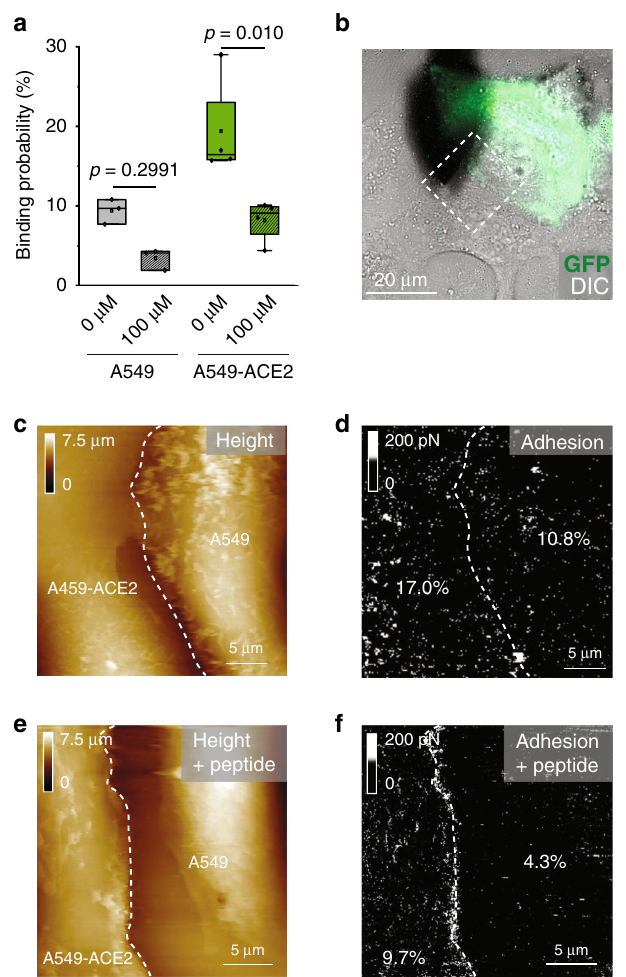
Fig. 5 Blocking of S1-subunit binding using ACE2-derived peptide on living cells. a Box plot showing that the reduction of binding probability measured the S1-subunit-derivatized tip and a mixed culture of A549 and A549 – ACE2 cells upon injection of the [22 – 57] ACE2-derived peptide. The square in the box indicates mean, the colored box indicates the 25th and 75th percentiles, and the whiskers indicate the highest and the lowest values of the results. b Overlay of eGFP and DIC images of a mixed culture of A549 and A549 – ACE2 – eGFP cells. FD-based AFM topography images ( c , e ) and the corresponding adhesion map ( d , f ) recorded in the speci fi ed area in ( b ) (scanned with a scan angle) before ( c , d ) and after ( e , f ) incubation of the tip with the [22 – 57] ACE2-derived peptide. The frequency of adhesion events is indicated. Data are representative of at least N = 4 cells from N = 2 independent experiments. P values were determined by two-sample t test in Origin. Source data are provided as a Source Data fi